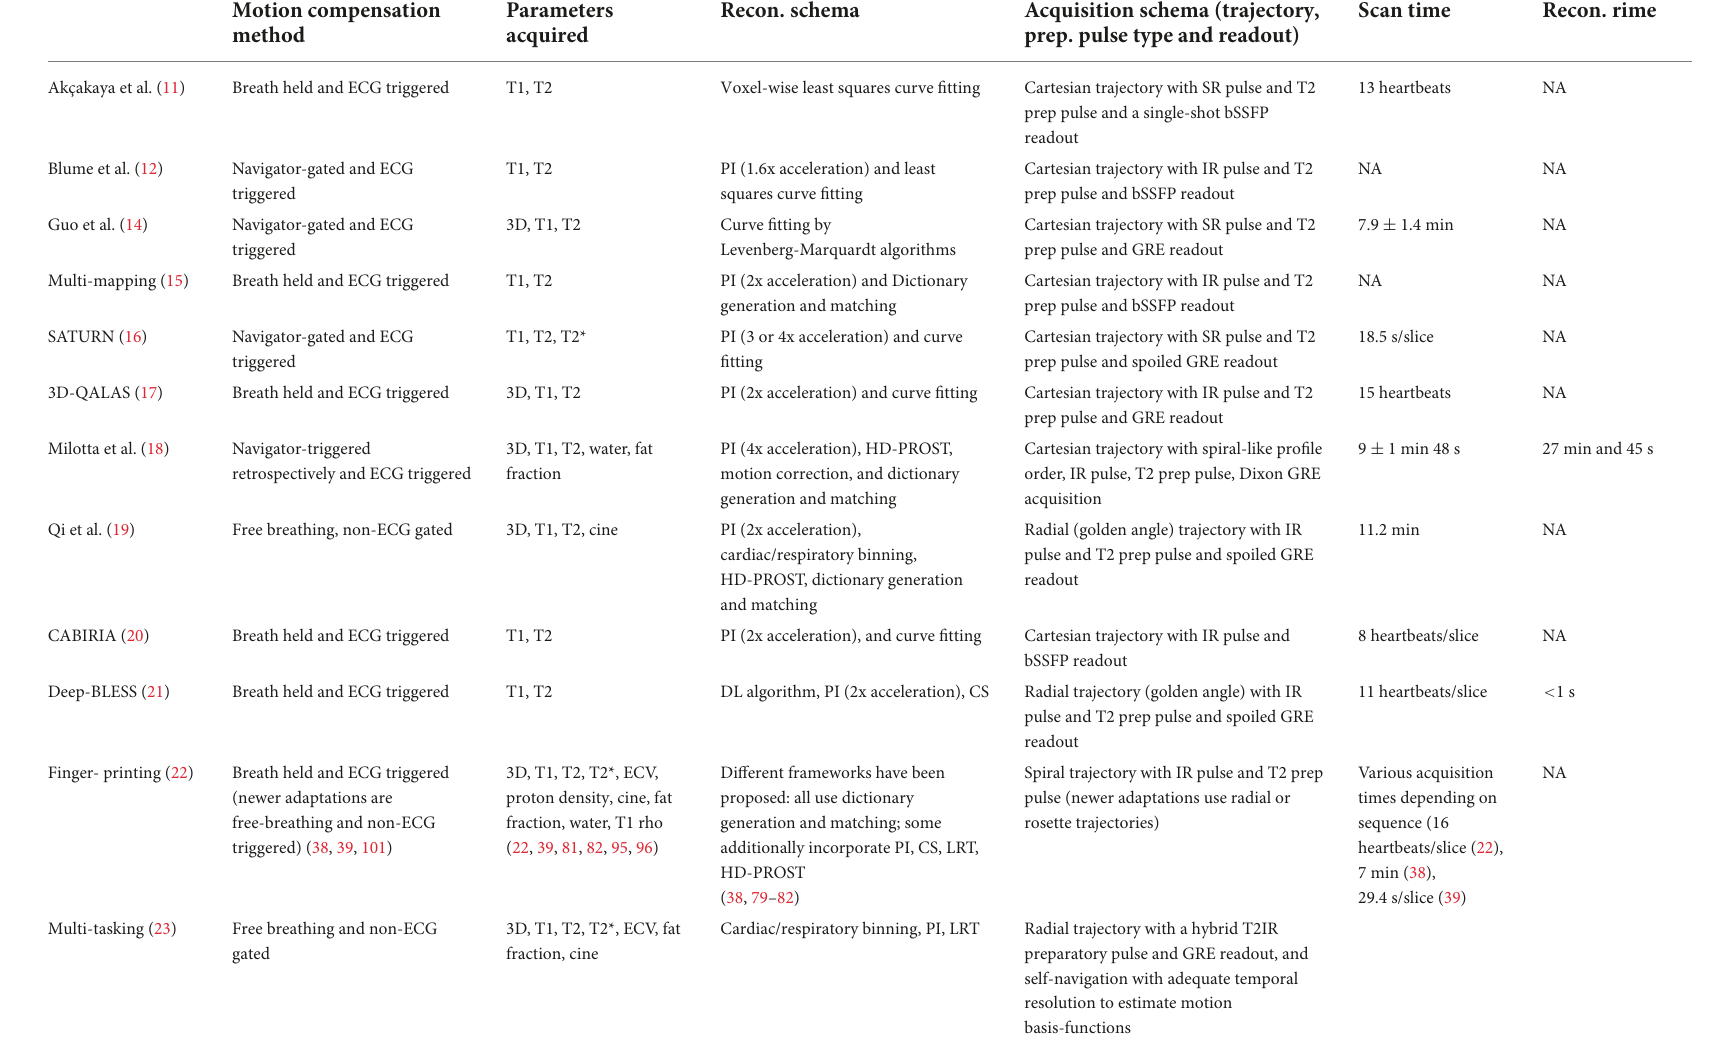
TABLE 2 Comparison of SMART methods discussed in this